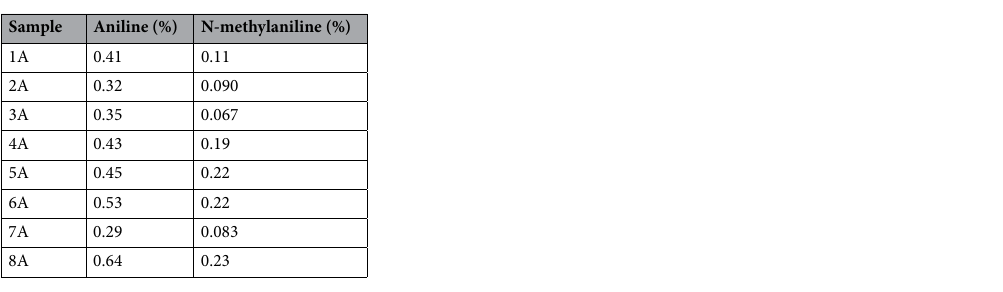
Table 1. Aniline and N-methylaniline concentration of different indigo samples. The percentages by weight are referenced to the indigo weight.